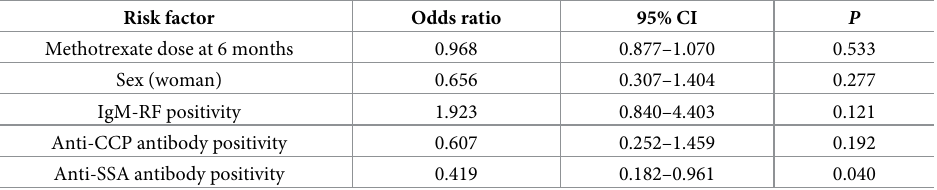
Table 4. Logistic regression analysis for the rate of achieving low disease activity according to the DAS28-CRP, including the methotrexate dose. Risk factor Odds ratio 95% CI P Methotrexate dose at 6 months 0.968 0.877–1.070 0.533 Sex (woman) 0.656 0.307–1.404 0.277 IgM-RF positivity 1.923 0.840–4.403 0.121 Anti-CCP antibody positivity 0.607 0.252–1.459 0.192 Anti-SSA antibody positivity 0.419 0.182–0.961 0.040 DAS28, 28-joint Disease Activity Score; CI, confidence interval; IgM-RF, IgM rheumatoid factor; anti-CCP,